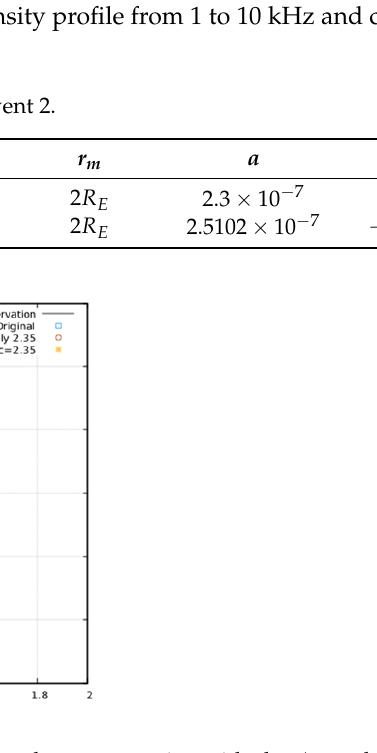
Figure 11. The calculated propagation times from the source point with the Arase location for the second event. The gray line shows the dispersion measured by Arase, the blue line shows the cal- culated dispersion using the reference electron density profile, the orange line shows the calculated dispersion using the modified electron density with constant c , and the yellow line shows the cal- culated dispersion using the modified electron density using Equation (6).